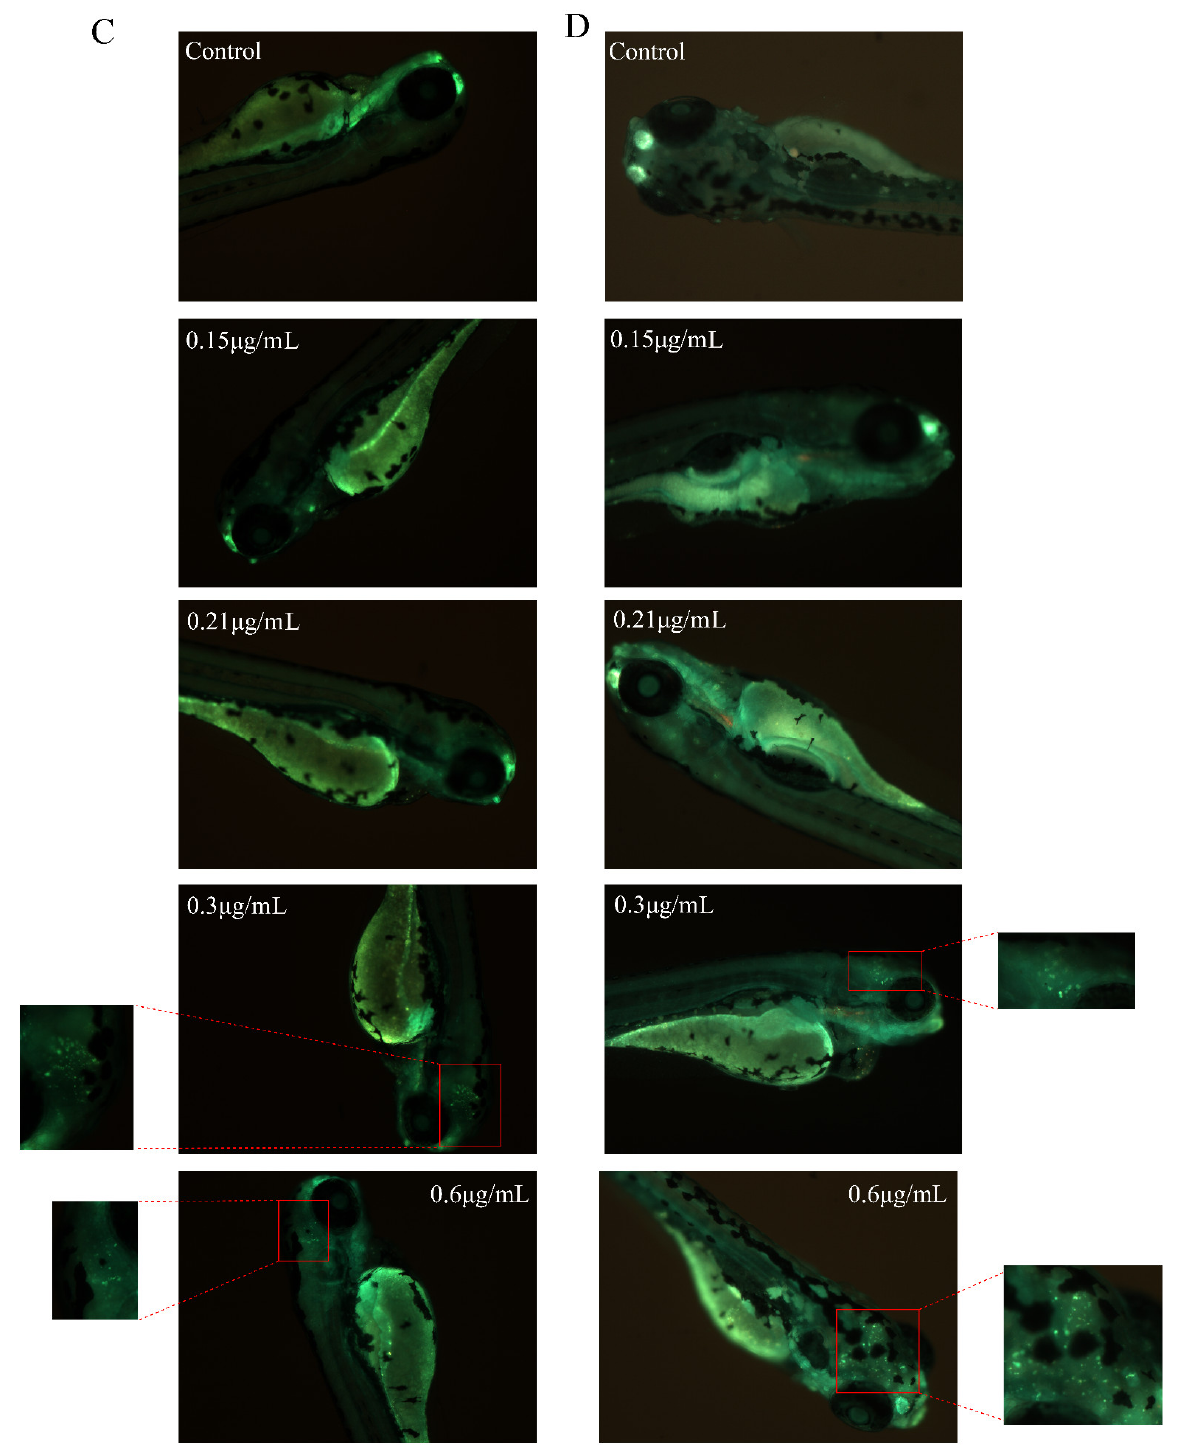
Figure 4. Representative images of whole-embryo cell death determined by acridine orange staining at 24 hpf ( A ), 48 hpf ( B ), 72 hpf ( C ), and 96 hpf ( D ) in the control and honokiol microemulsion-exposed groups. The red boxes indicate representative apoptotic cells in brain.